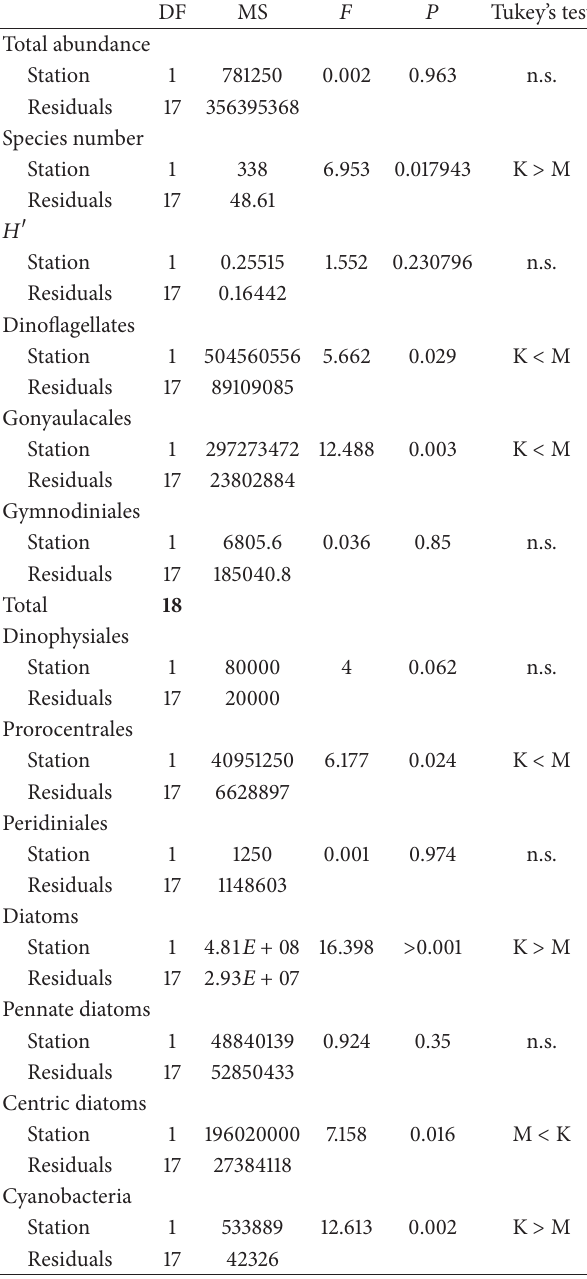
Table 3: ANOVA on microalgae abundances between controls and disturbedstations.M:Mahdia(controlstation);K:Skhira(disturbed station); n.s.: not